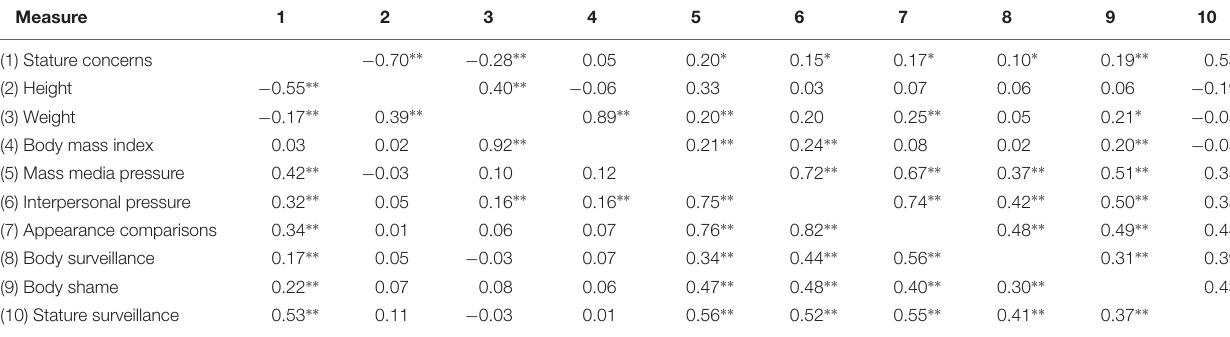
TABLE 2 | Correlations between all variables for women and men. Measure